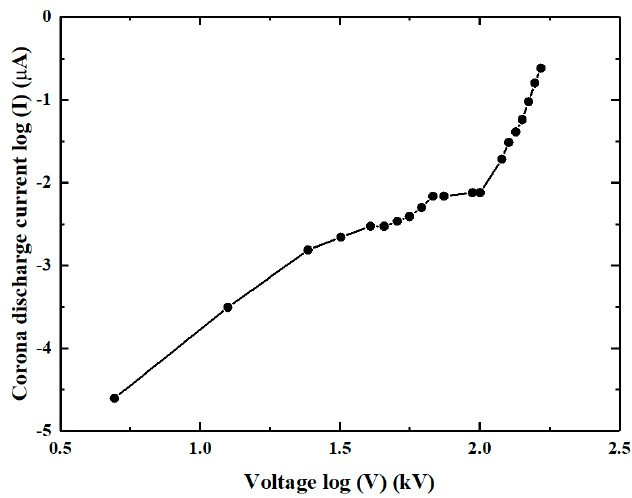
Figure 3. Corona discharge characteristics of the needle-plate electrode configuration.